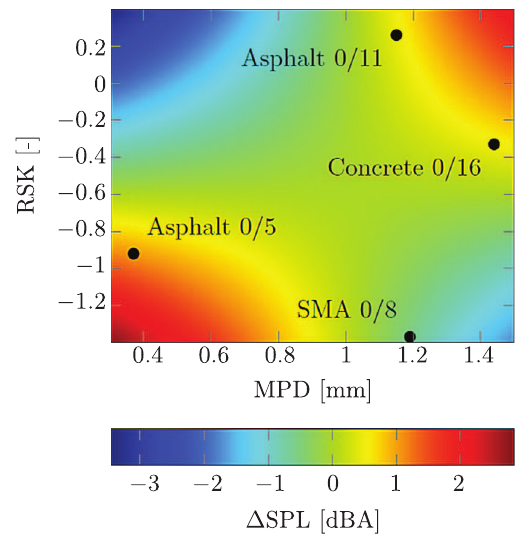
Figure 12. In fl uence of the interaction between the roughness amplitude MPD and the texture orientation RSK on the summer tire ’ s groove resonance noise. The result for the winter tire is similar but the SPL range is reduced by 28%. The black points correspond to the measurement